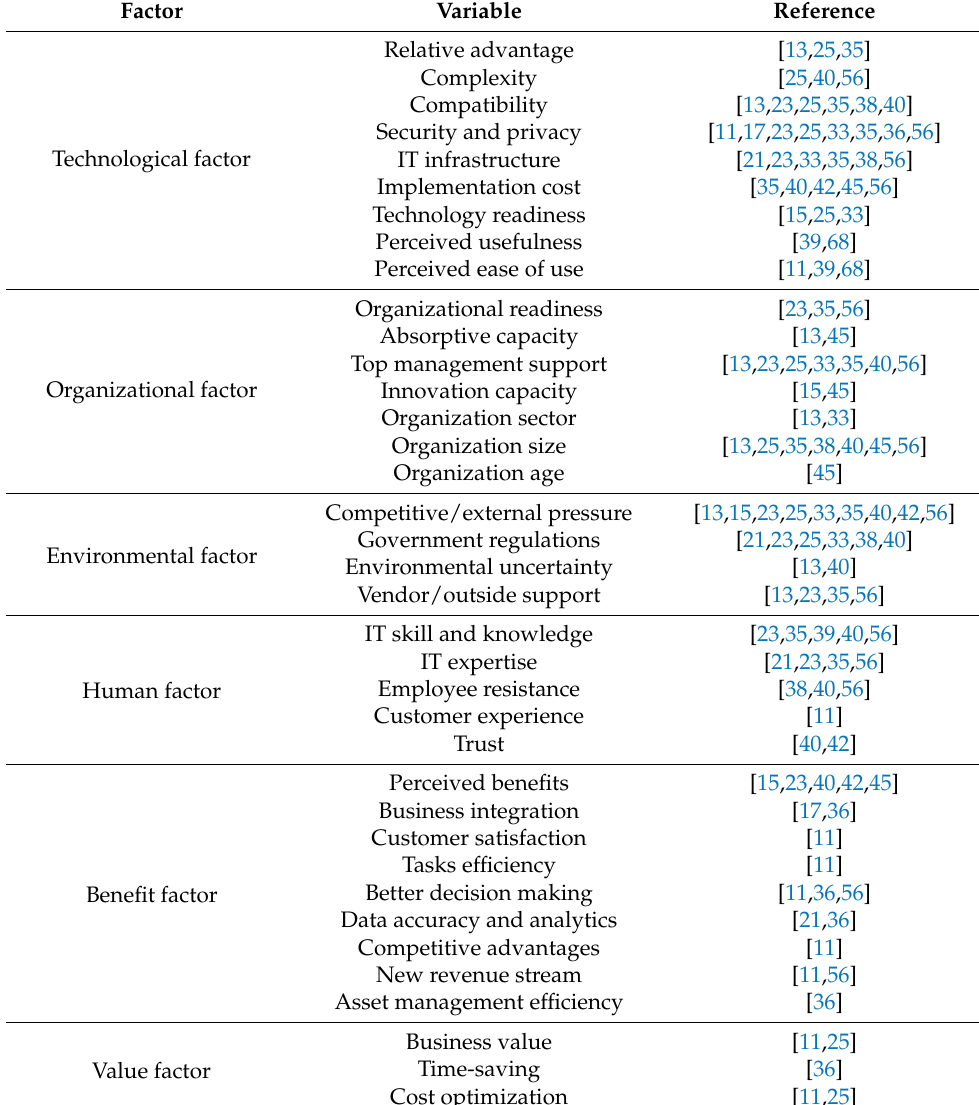
Table 6. Factors that influence the IoT adoption in